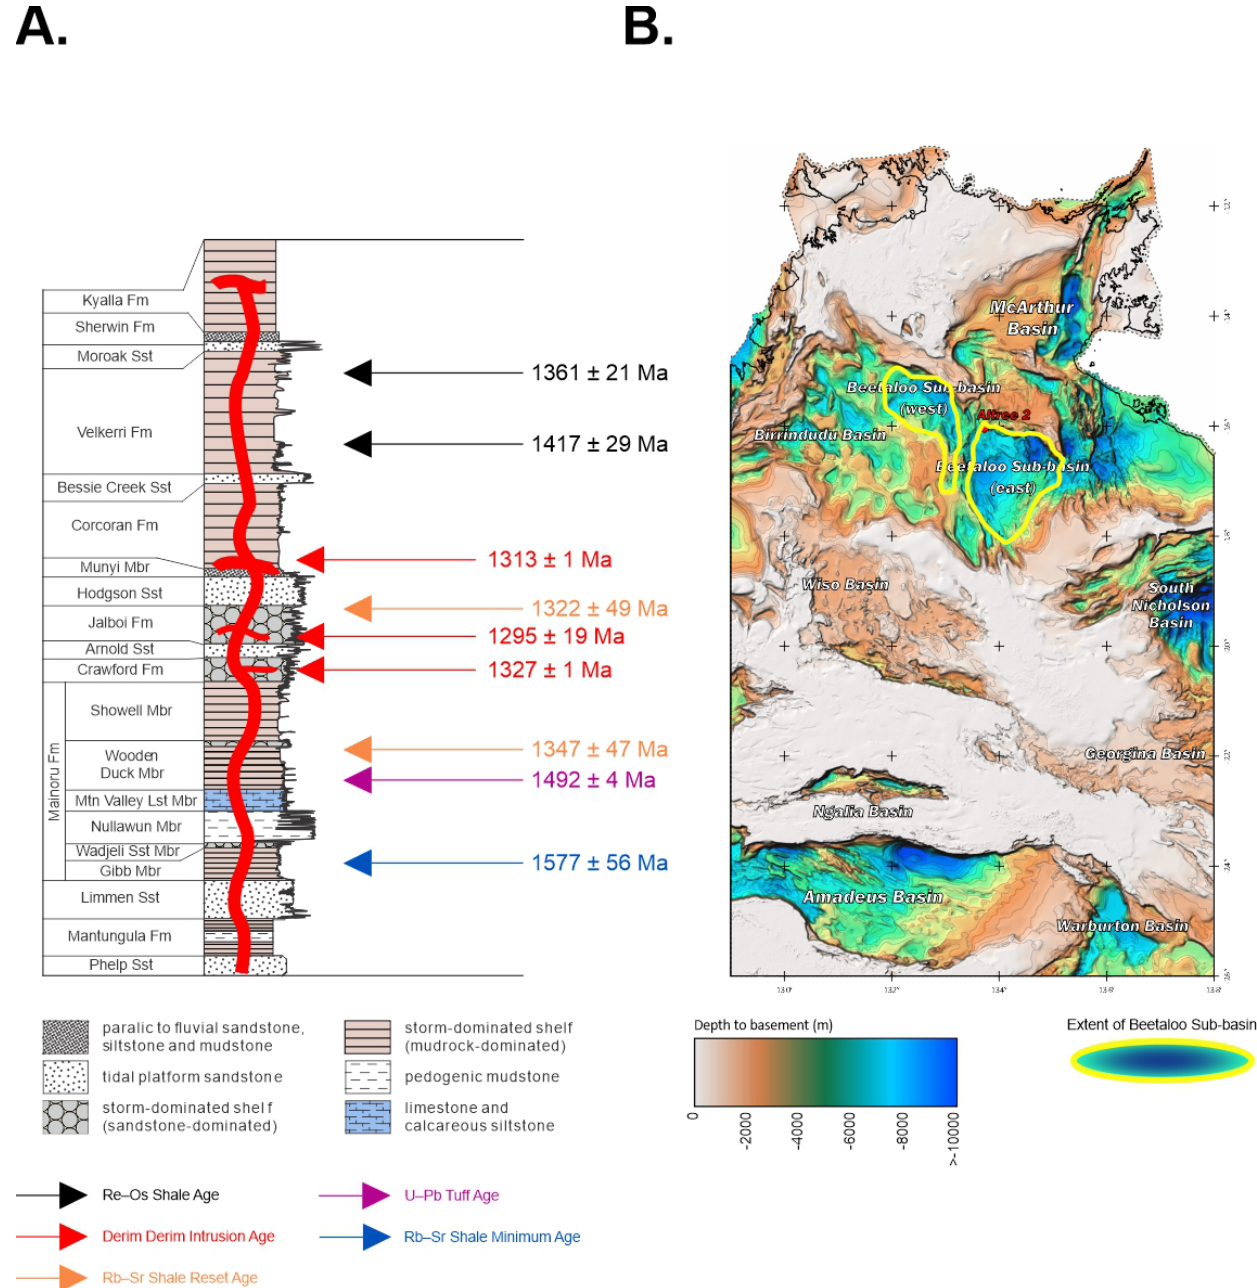
Figure 1. (a) Schematic stratigraphy and geochronological summary of the Roper Group (Abbott et al., 2001; Subarkah et al., 2021; Jackson et al., 1999; Southgate et al., 2000; Yang et al., 2020; Kendall et al., 2009). (b) Sample location and depth to basement map for the McArthur Basin, adapted from Frogtech Geoscience